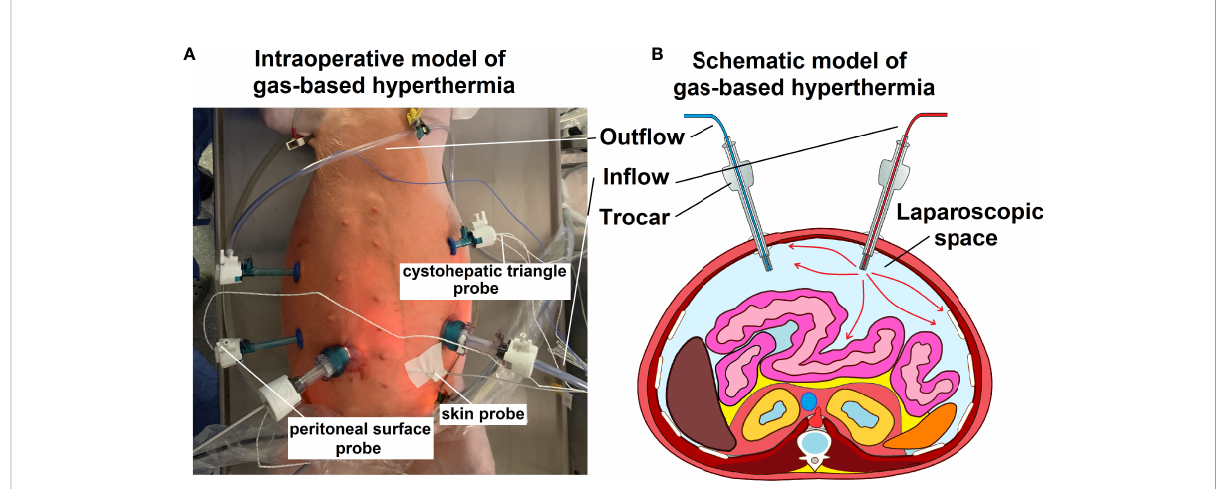
FIGURE 1 (A) Intraoperative model of gas-based i.p. hypertermia in an in-vivo swine model. Multiple trocars are placed for visual control, including at the in- and out fl ow and the entrance point for the temperature sensors. (B) Schematic model (transverse section) of the abdominal cavity including the in- and out fl ow trocar